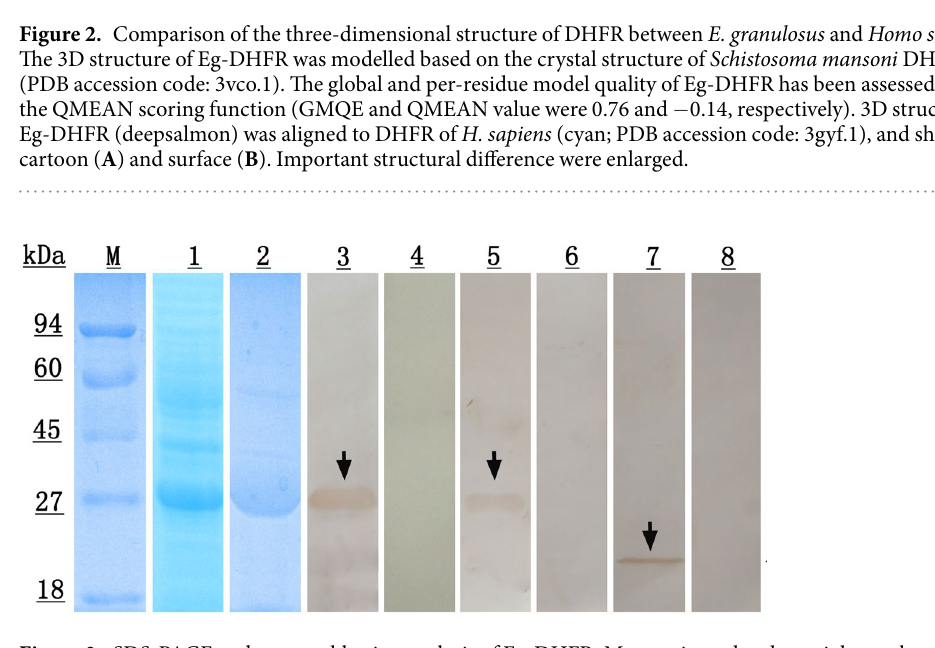
Figure 3. SDS-PAGE and western blotting analysis of Eg-DHFR. M, protein molecular weight markers; lane 1, E. coli BL21 (DE3) lysate from IPTG-induced cells expressing rEg-DHFR; lane 2, purified rEg-DHFR; lane 3, purified rEg-DHFR probed with anti-rEg-DHFR rabbit serum; lane 4, purified rEg-DHFR probed with native (preimmune) rabbit serum; lane 5, purified rEg-DHFR probed with the serum of E. granulosus infected sheep; lane 6, purified rEg-DHFR probed with native (healthy) sheep serum; lane 7, the total protein from protoscoleces probed with anti-Eg-DHFR rabbit serum; lane 8, the total protein from protoscoleces probed with native (preimmune) rabbit